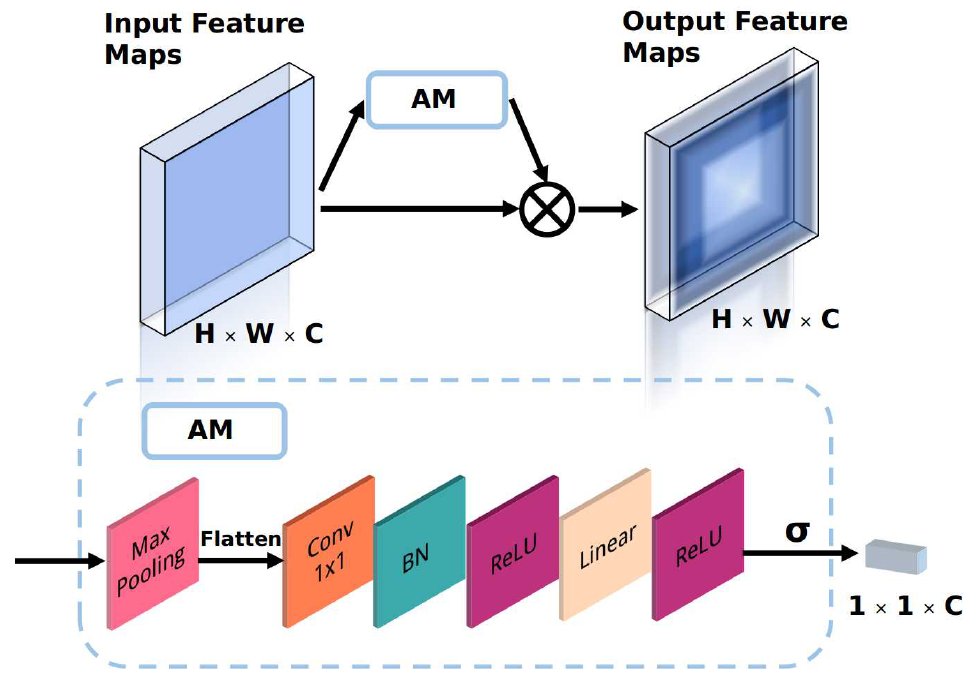
Figure 2. The proposed attention module. The AM is an automatic weighting module that learns the channel weights of the input feature maps. As shown in Figure 2, the input F s is first downsampled using the global i max-pooling operation to retain important information while reducing the computational cost. The downsampled feature maps are then flattened into a one-dimensional vector. The flattened vector is then sent to a convolution layer with a 1 × 1 kernel to extract features from the vector and adjust its dimension. The extracted features are sent to the batch norm (BN) layer and activated using the ReLU function to speed up the training and convergence speed of the module and increase its nonlinear representation ability. After these operations, an FC layer (Linear) with ReLU as the activation function is adopted to output the CAF with a size of 1 × 1 × C . The final output is generated using the sigmoid function to convert the values of the CAF to a range of 0 to 1; these values can be considered the importance scores of the channels in the F s i